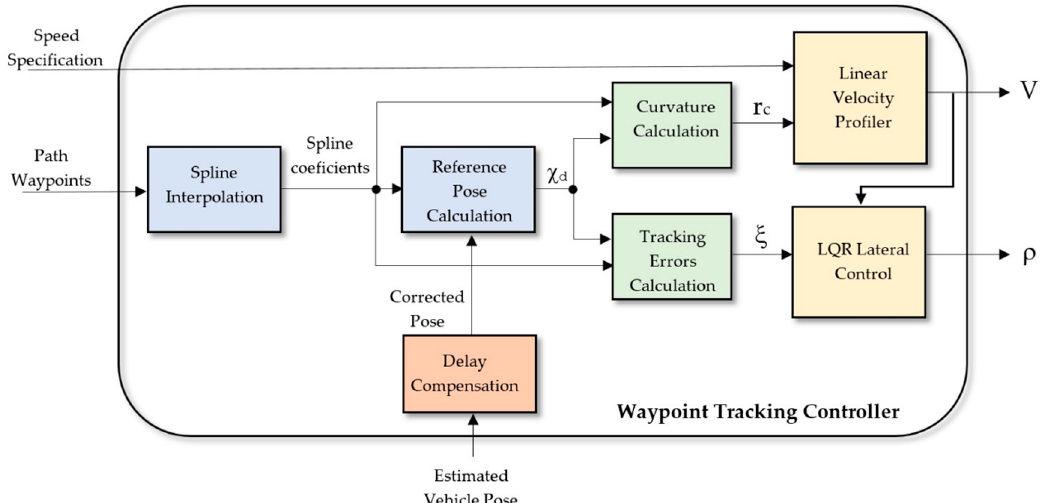
Figure 2. Global architecture of the proposed Waypoint Tracking Controller. Inputs are: a set of path waypoints, an external speed specification and the estimated vehicle pose. Outputs are: linear speed V and steering angle ρ . The main subsystems are a Spline Interpolator, a Linear Velocity Profiler, a Linear Quadratic Regulator (LQR) Lateral Controller and a Delay Compensation System.